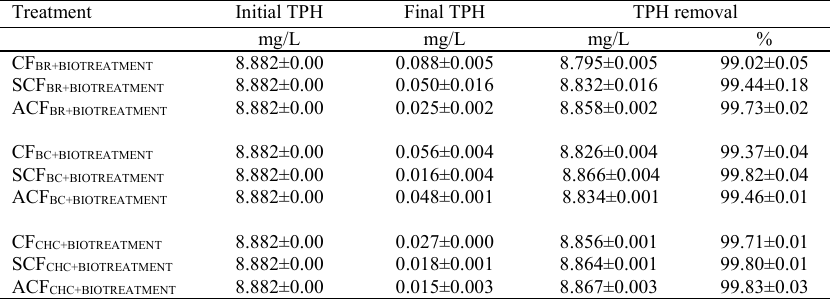
Table 2: Results for coupling effect of biodegradation and filtration